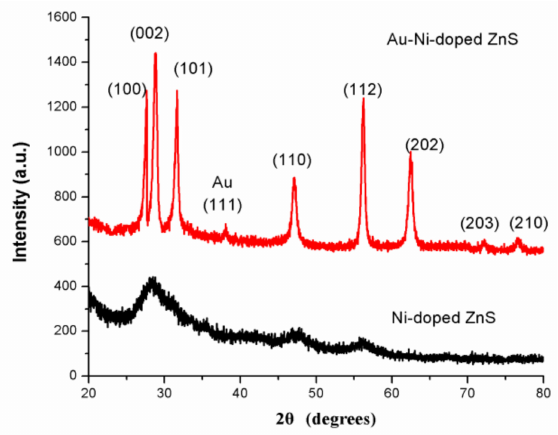
Figure 1. XRD pattern of Au–Ni-doped ZnS nanospheres ( up ) and Ni-doped ZnS nanospheres ( down